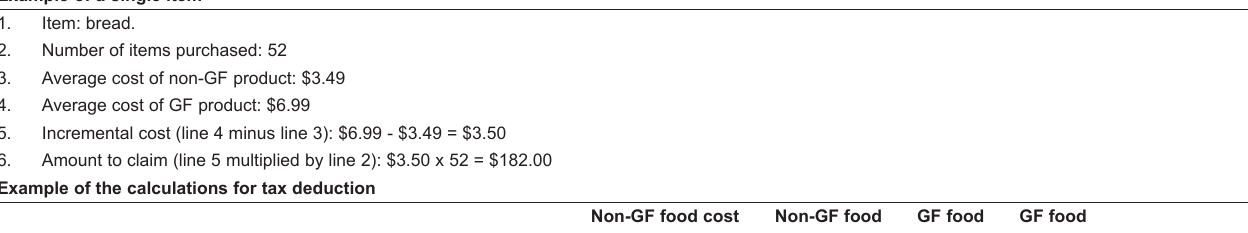
TABLE 1 Example tax deduction system for a single gluten-free (GF) item and calculations for tax deduction Example of a single